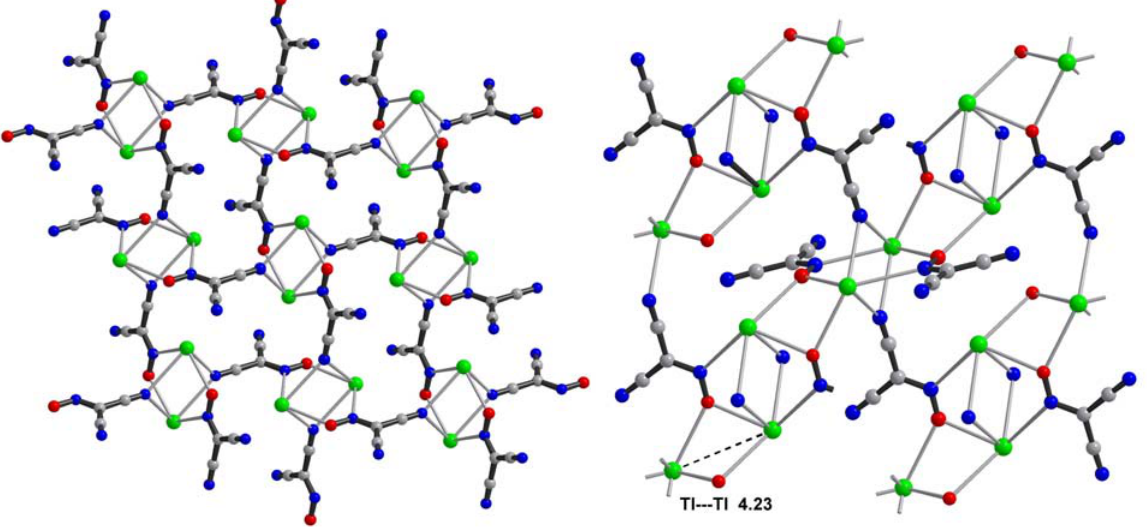
Figure 9. Two arbitrary projections of the crystal packing showing the organization of a 3D coordination-polymeric framework of